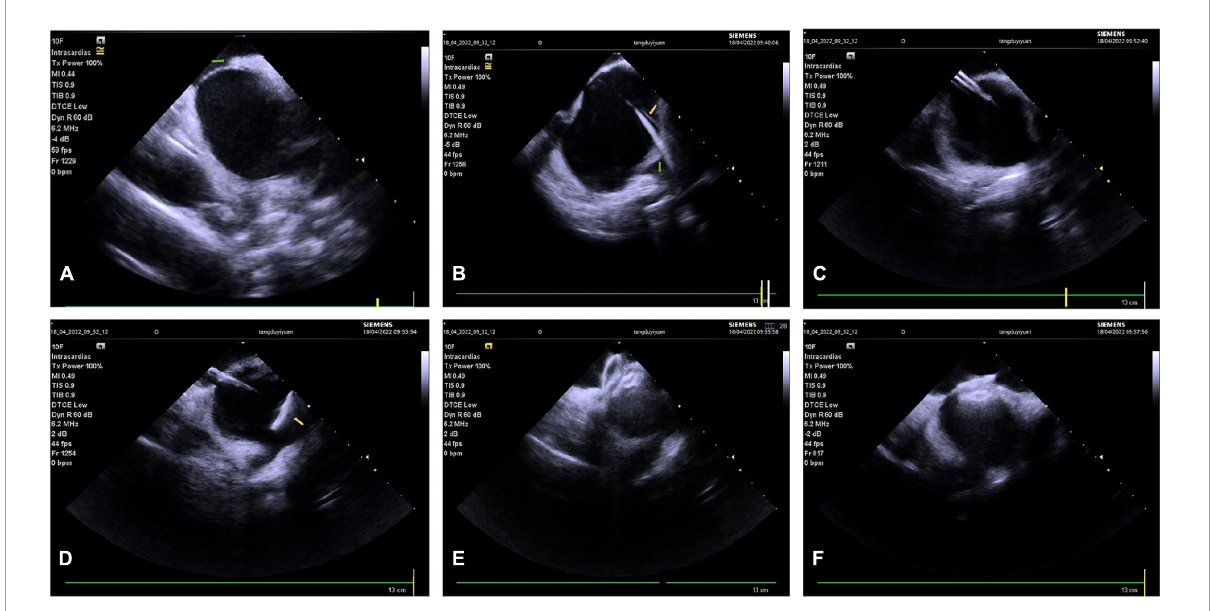
FIGURE9 Patent foramen ovale closure procedure guided by ICE. (A) PFO slit (green arrow). (B) The guidewire passes through the PFO slit (yellow arrow points to the highlighted echo which represents the guidewire, and green arrow points to the left superior pulmonary vein). (C) Send the delivery sheath to the ostium of the left superior pulmonary vein. (D) Release the left plate of the closure device (the yellow arrow points to the left plate). (E) Perform a pull test after the closure device is fully expanded. (F) The closure device is released. PFO, patent foramen